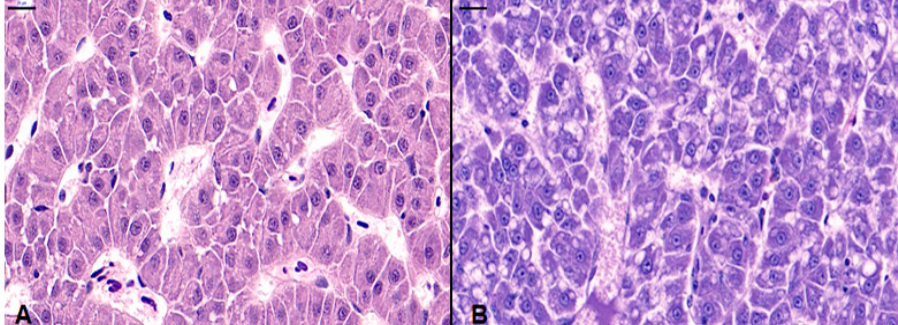
Figure 4. Histopathology of liver of healthy rainbow trout ( A ) and a moribund rainbow trout with Chryseobacterium balustinum WLT infection ( B ). Necrosis and cytoplasmic vacuolation can be observed in hepatic cells on liver of diseased fish. Slides were stained with hematoxylin and eosin. Scale bars = 20 μ m. Table 1. Antibiotic susceptibility test performed on C. balustinum WLT by disk diffusion method (R: resistant, S: susceptible, I: intermediate).